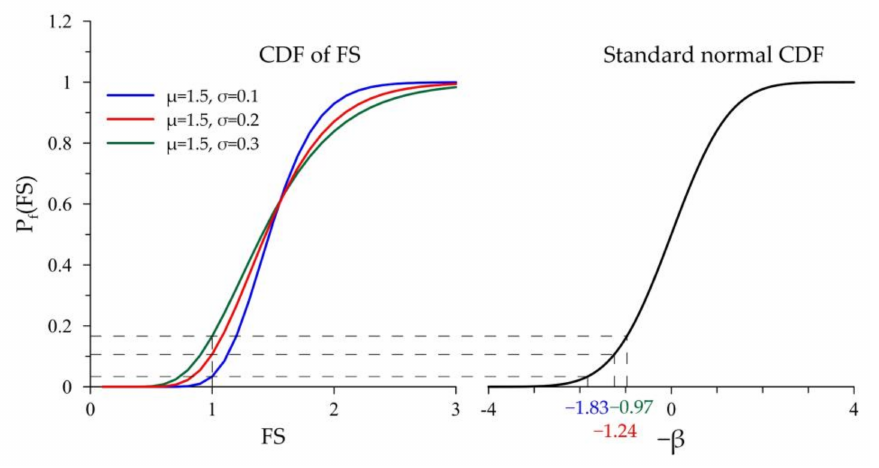
Figure 3. A graphic illustration of the relation of β , P f for different values of system